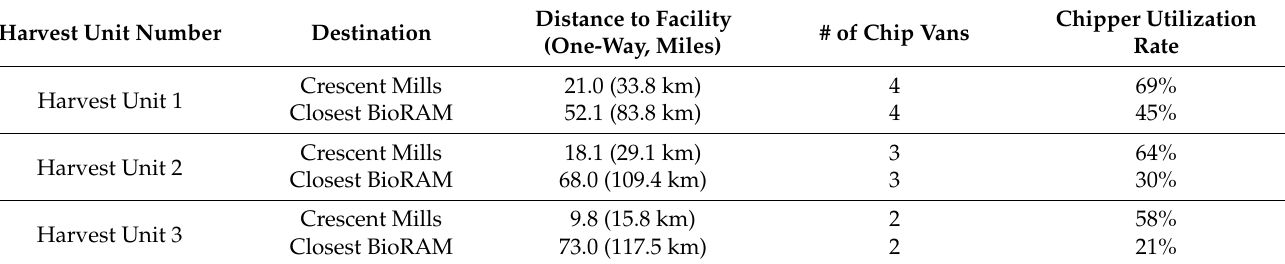
Table 3. Chipper utilization rates based on number of chip vans and biomass